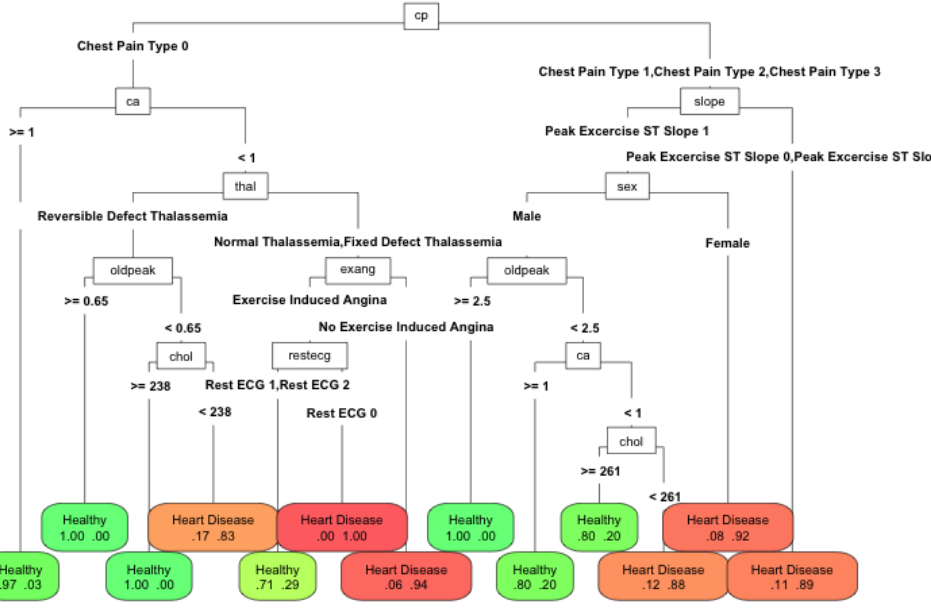
Figure 7. Performance of RPART with 100% of features with a maximum tree depth of